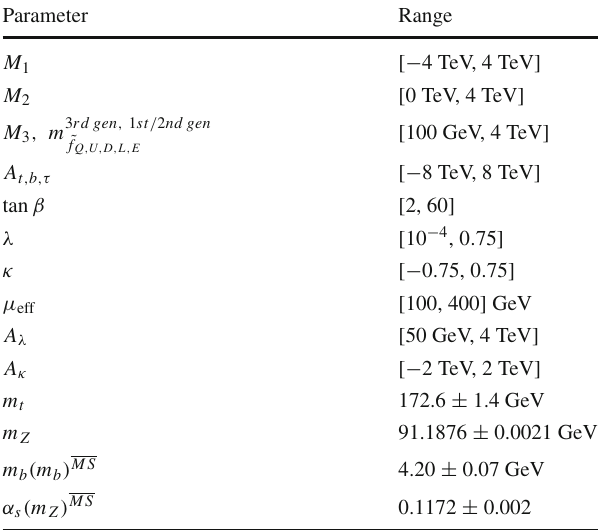
Table3 The26pNMSSMparametersandtheircorrespondingflatprior probability density distribution ranges. The SM parameters were varied according to Gaussian distributions with the shown central values and standard